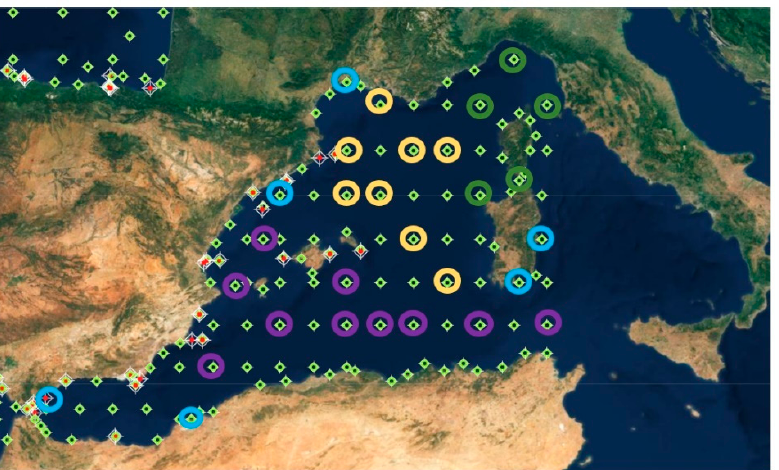
Figure 1. Distribution of the points SIMAR studied. The green points are the nodes where oceano- graphic information is showed, representing the colored rings, represents the different areas to be analyzed. Source: Author based on the cartography provided by Puertos del Estado . Spanish Ministry of Transport (2020).